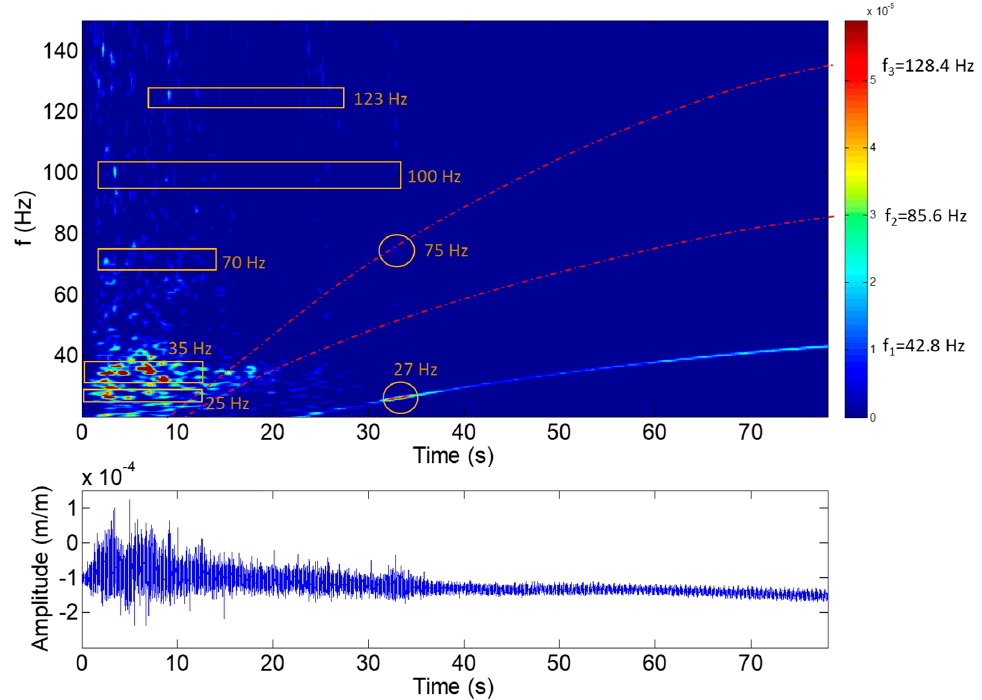
Figure 9. Joint time–frequency plot of a strain-gauge signal (crown side, pressure side, blade 7) during the initial hit.